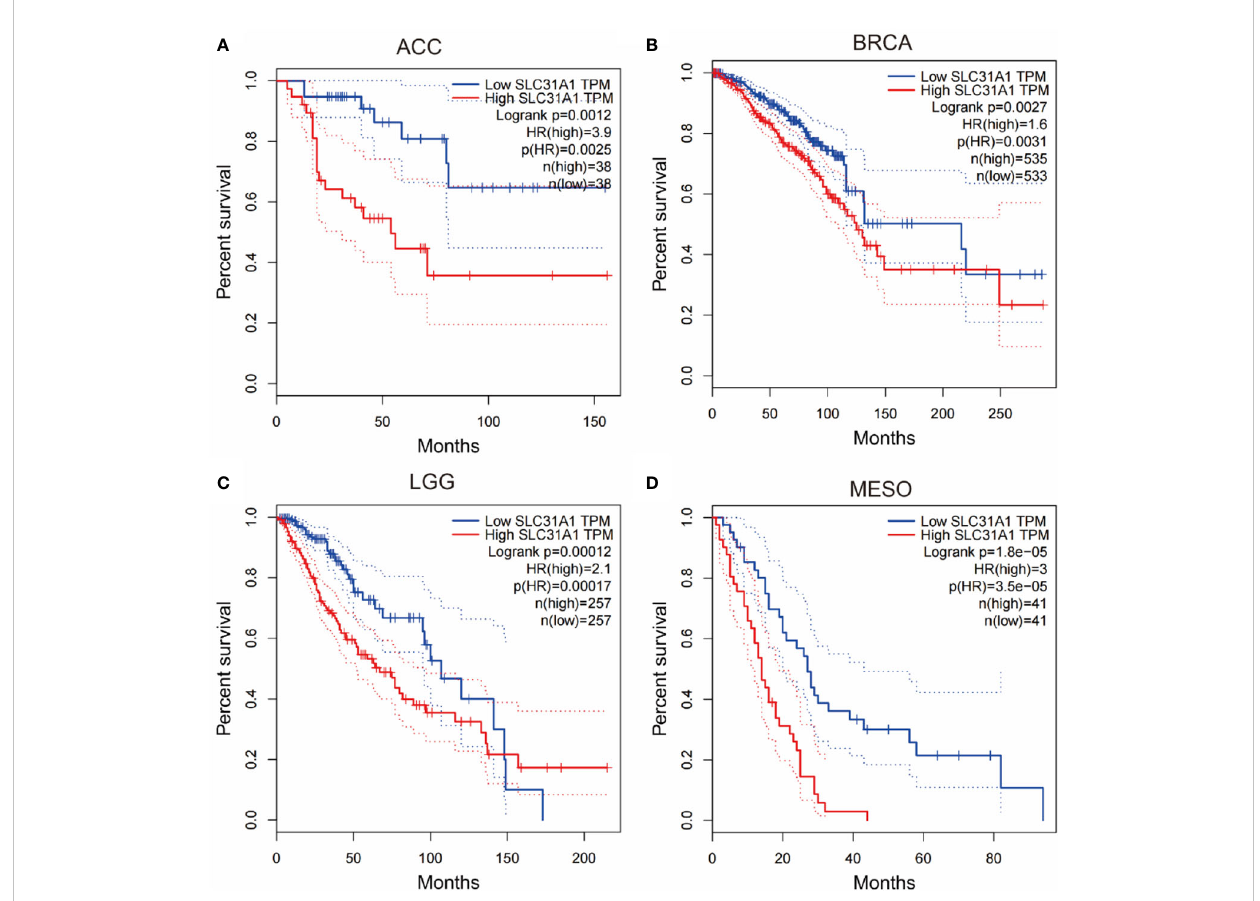
FIGURE 2 Survival curves for overall survival of high versus low expressing SLC31A1. (A) ACC, adrenocortical carcinoma; (B) BRCA, breast invasive carcinoma; (C) LGG, brain lower grade glioma; (D) MESO, mesothelioma. The overall survival rate of low expression of SLC31A1was signi fi cantly higher than that of high expression of SLC31A1. SLC31A1, solute carrier family 31 member 1 (copper ion transporter); HR, hazard rate. (http://gepia.cancer-pku.cn/ index.html; Accessed 10 October